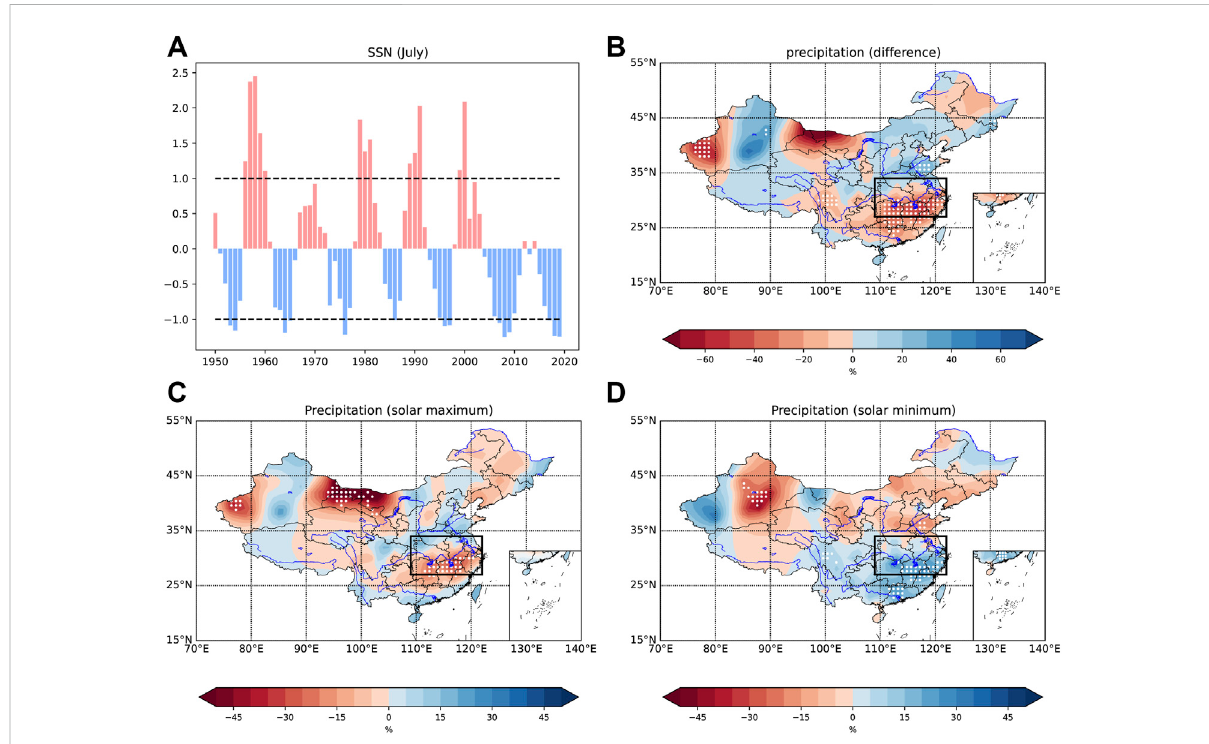
FIGURE 3 Normalized SSN (A) and composite map of precipitation anomaly percentage: (B) the difference between solar maximum and minimum, (C) in solar maximum, (D) in solar minimum. White dotted regions indicate signi fi cant correlations satisfying the 95% con fi dence level. The range of the MLRYR (rectangle) is consistent with Figure